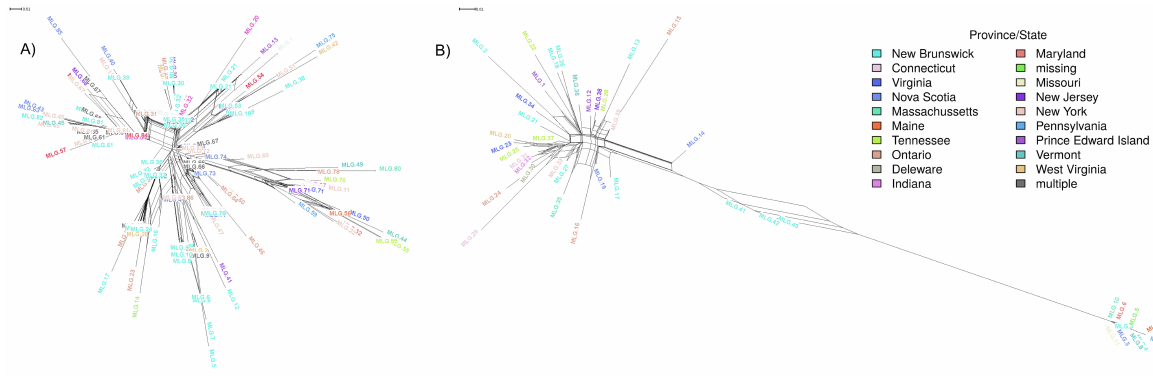
Figure 4. Neighbor-network constructed using SplitsTree using ( A ) 9 microsatellite loci and ( B ) 53 SNP loci. Parallel edges in this network indicate incongruence with a perfect monophyletic